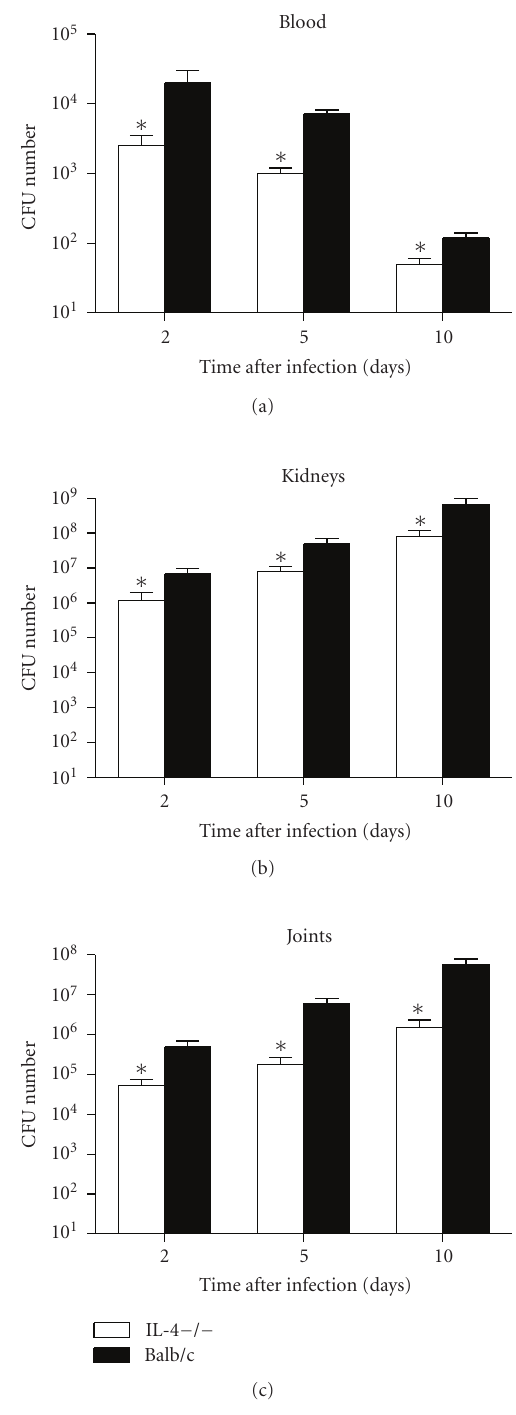
Figure 3: Bacterial growth in blood, kidneys and joints. IL-4- deficient and wt mice were infected with 1 × 107 6 GBS/mouse, and blood and organs were removed and processed as detailed in materials and methods (see Section 2). The values represent the mean ± SD of three separate experiments each consisting of 20 mice per experimental group. Three mice per group were sacrificed at each time point. Results are expressed as number of CFU per ml of blood, per whole organ, or per ml of joint homogenate. Statistical di ff erences between the experimental groups were marked with asterisk ( P < .